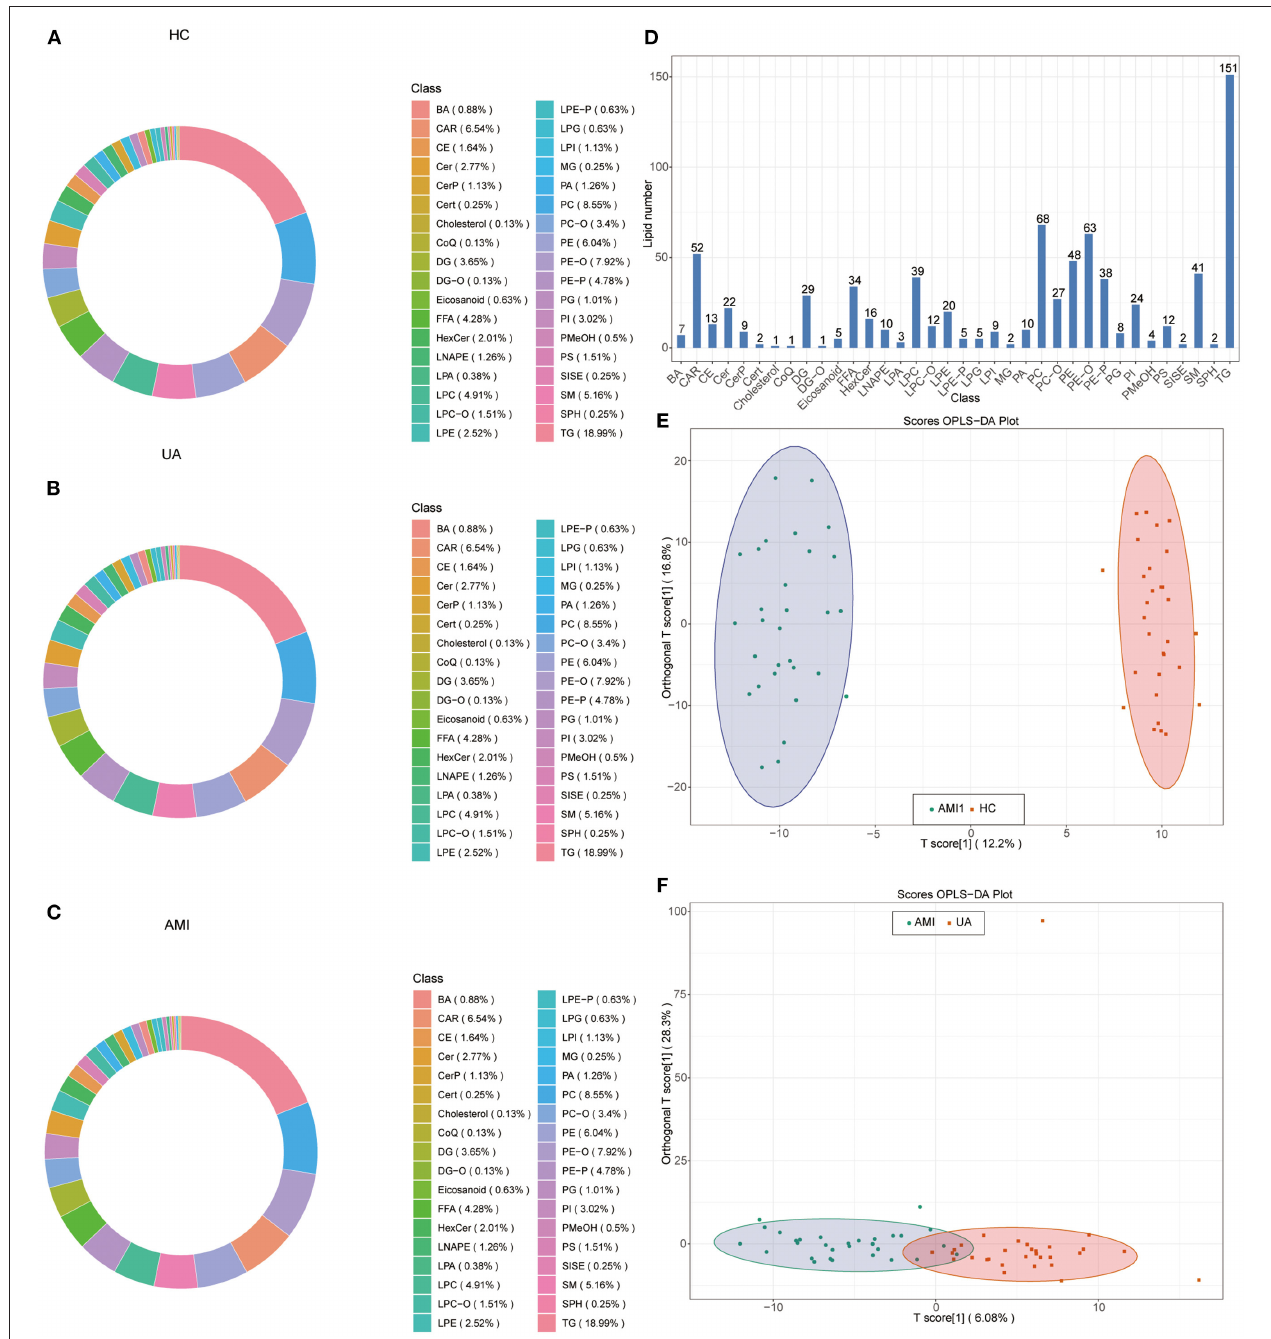
FIGURE 2 | Identification of lipid components and orthogonal partial least squares discriminant analysis (OPLS-DA). Circular diagram of lipid subclass composition in healthy control (HC) group (A) , unstable angina (UA) group (B) , and acute myocardial infarction (AMI) group (C,D) . Total detected lipid subclasses and the number of lipid compounds contained in each subclass. OPLS-DA score plot in AMI vs. HC (E) and AMI vs. UA (F) .